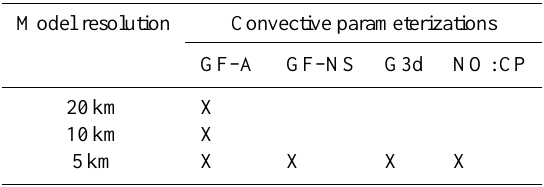
Table 1. Summary of model runs Model